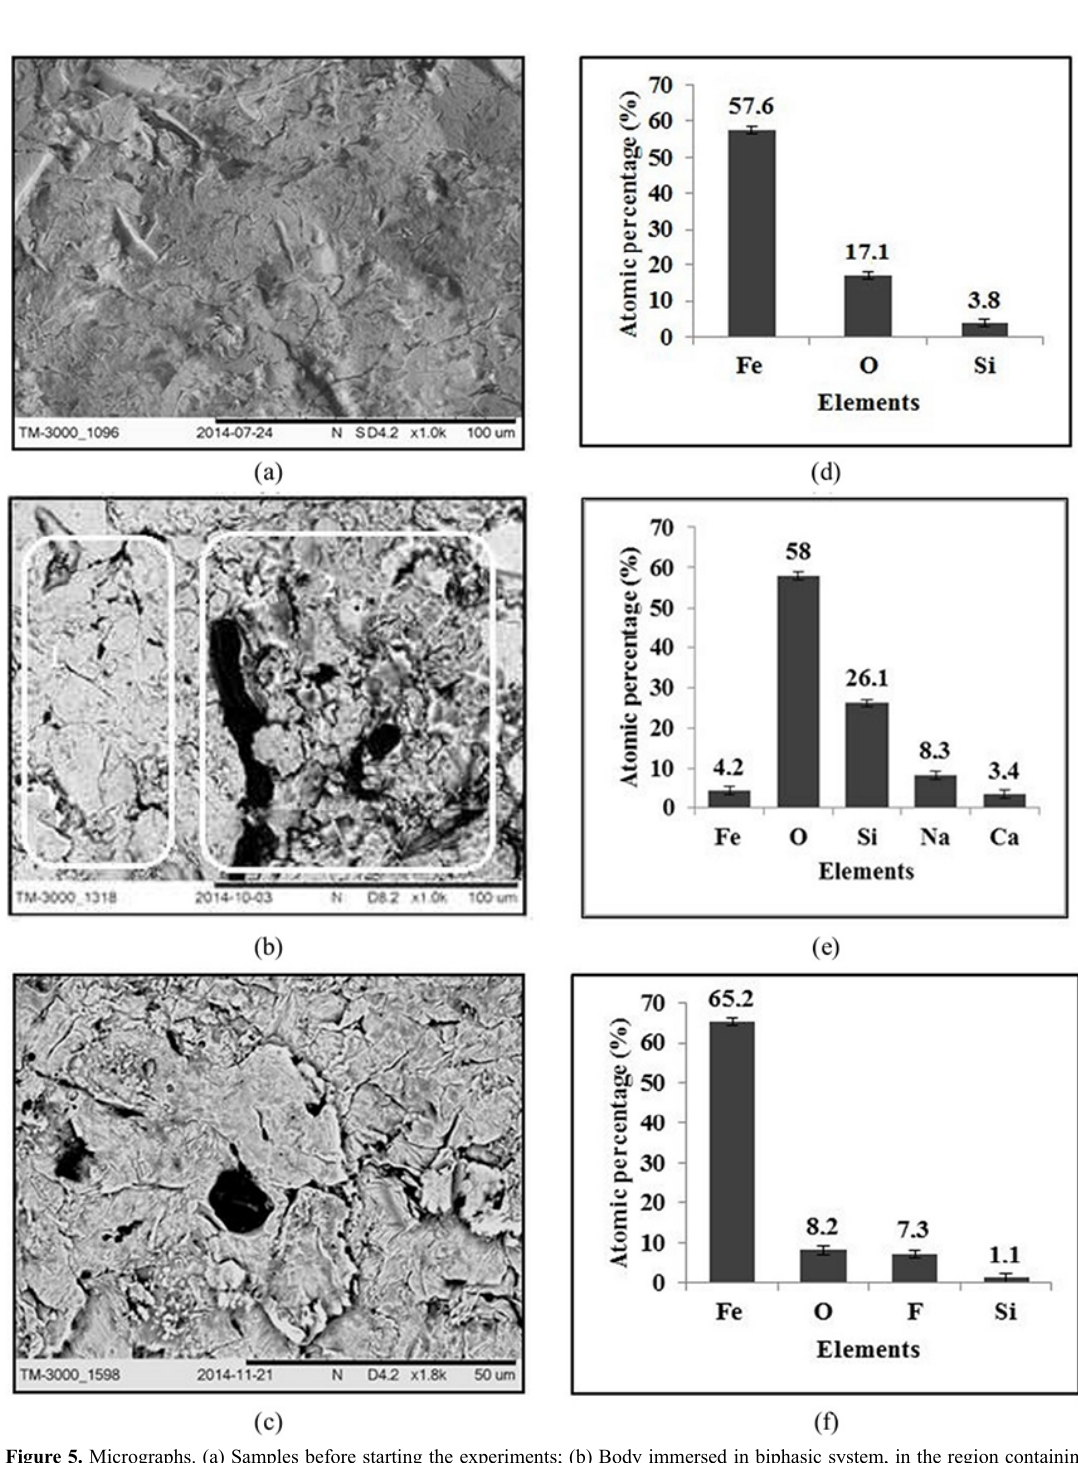
Figure 5. Micrographs. (a) Samples before starting the experiments; (b) Body immersed in biphasic system, in the region containing water, after 60 days of immersion; (c) Body immersed in pure diesel oil after 90 days of immersion; (d, e, f) respectively. Magnification: (a) 1000X; (b) 1000X; (c)